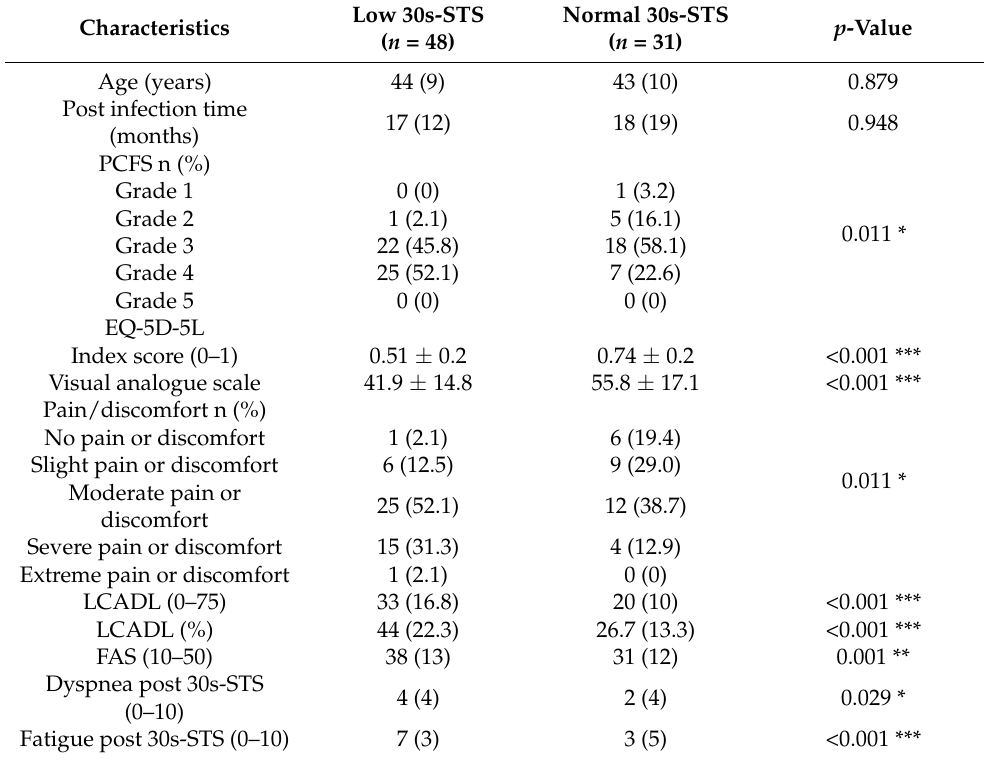
Table 2. Comparison between low and normal physical